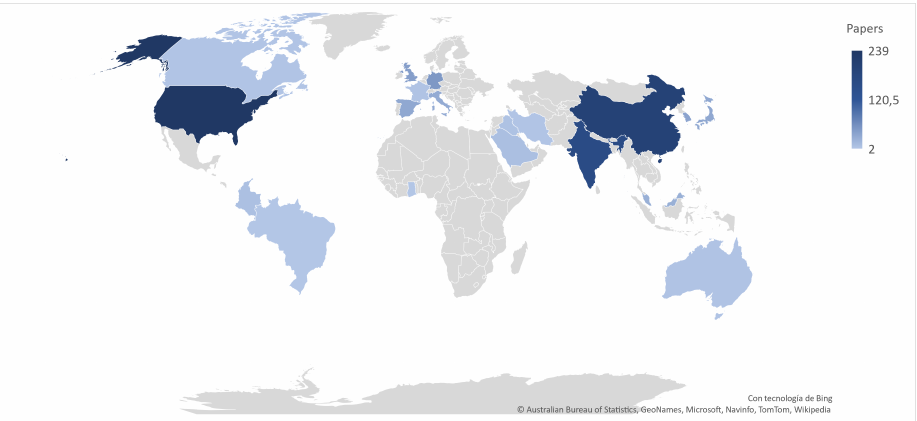
Figure 5. Countries with the highest scientific production at the point where CSP and ML